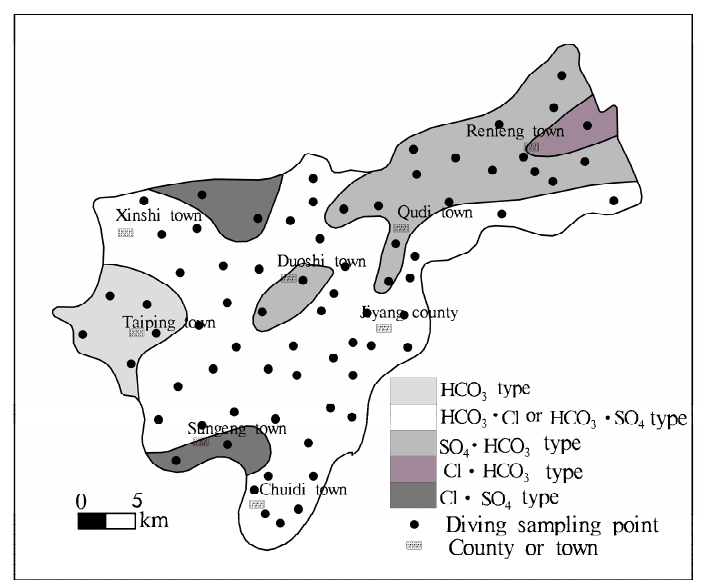
Figure 3. Variation trend of the shallow groundwater component.